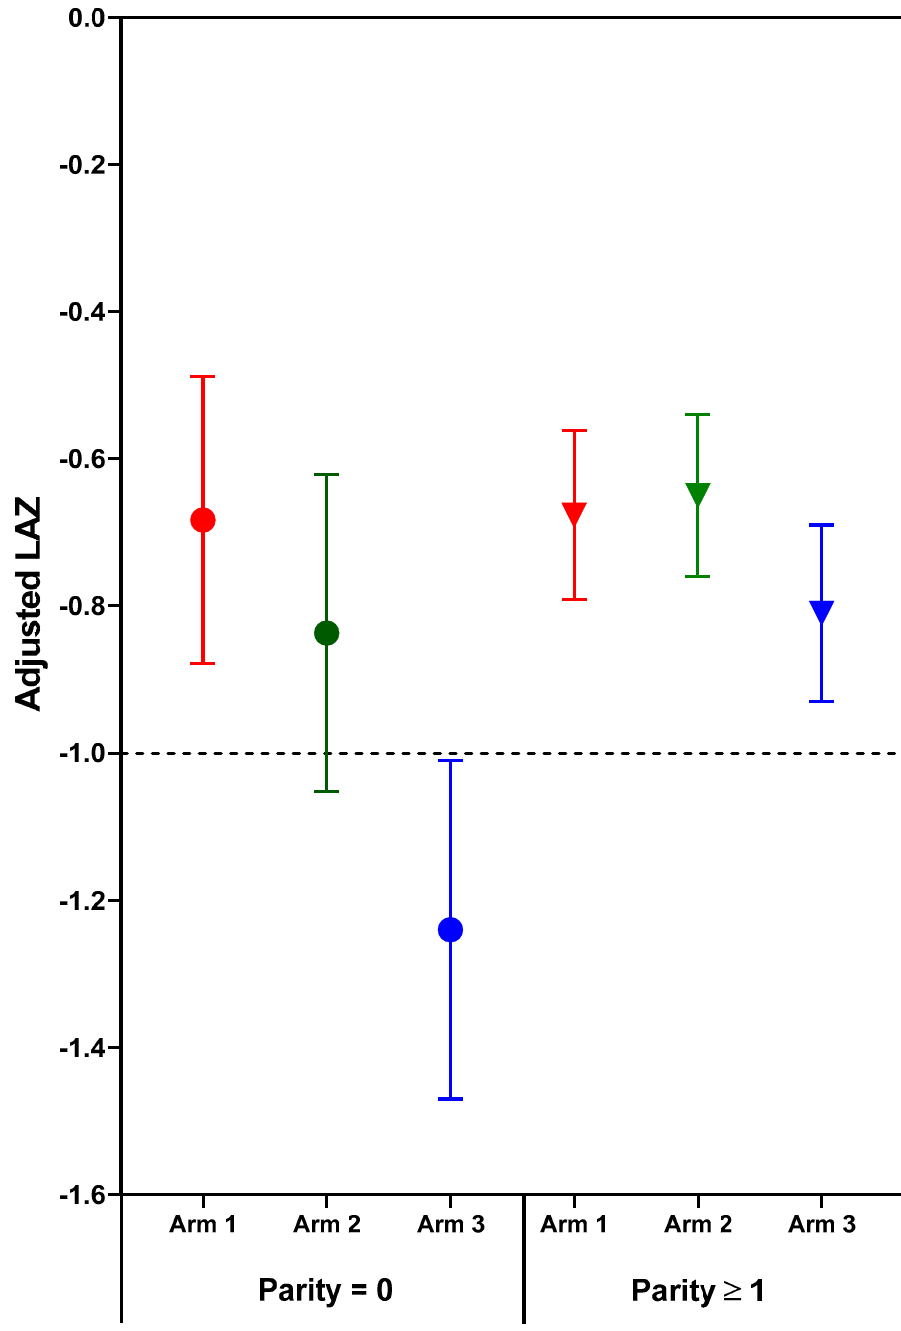
Figure 2. Adjusted mean (95% confidence interval) length-for-age z -scores (LAZ) of neonatal outcomes by treatment arm and parity. Horizontal line at LAZ − 1 depicts a length deficit that has predicted a high risk of stunting at two years. Circles indicate parity = 0; Triangles indicate parity ≥ 1.